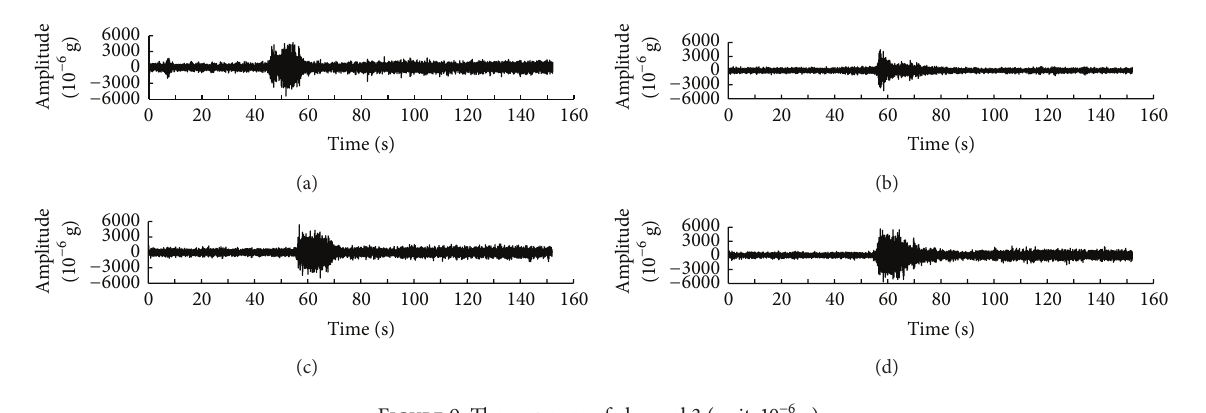
Figure 9: The response of channel 3 (unit: 10 −6 g).